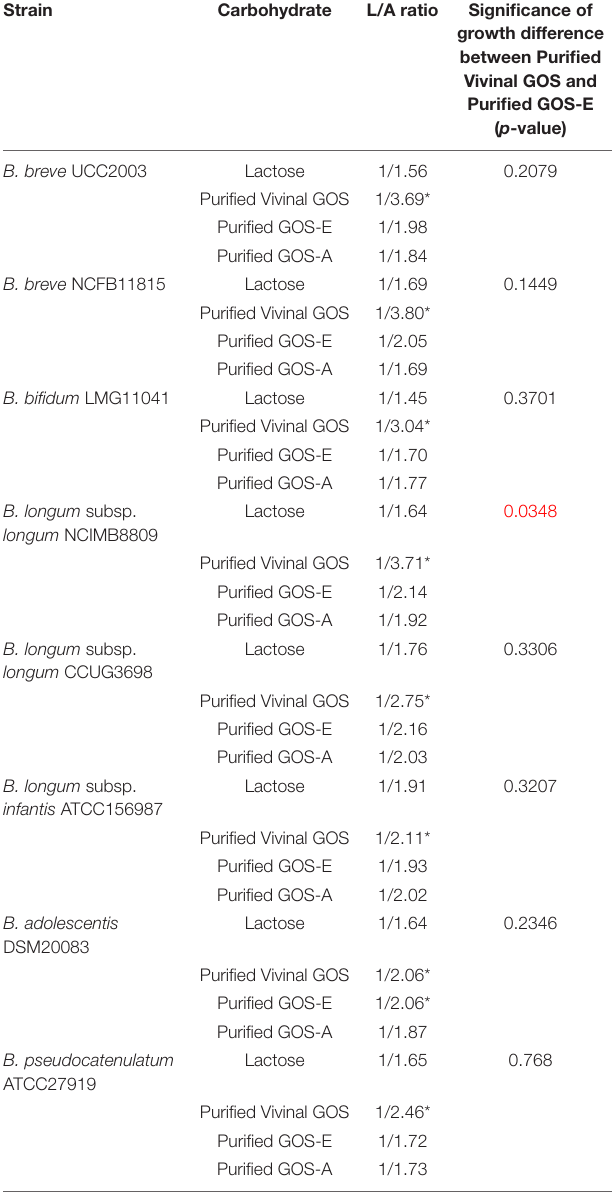
TABLE 6 | Lactate/Acetate ratio at 24 h of growth experiment and significant bifidobacterial growth. Strain Carbohydrate L/A